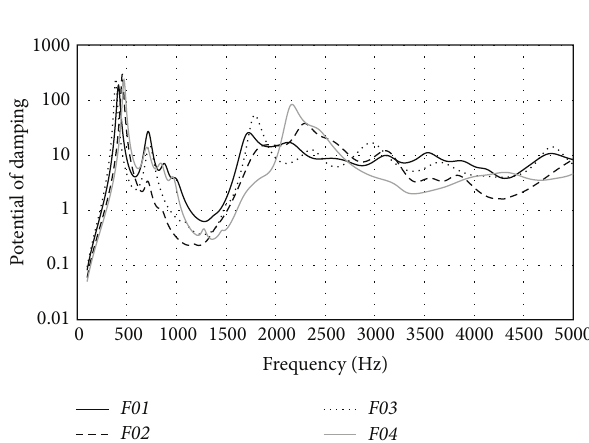
Figure 12: Damping potential for four multilayer damper